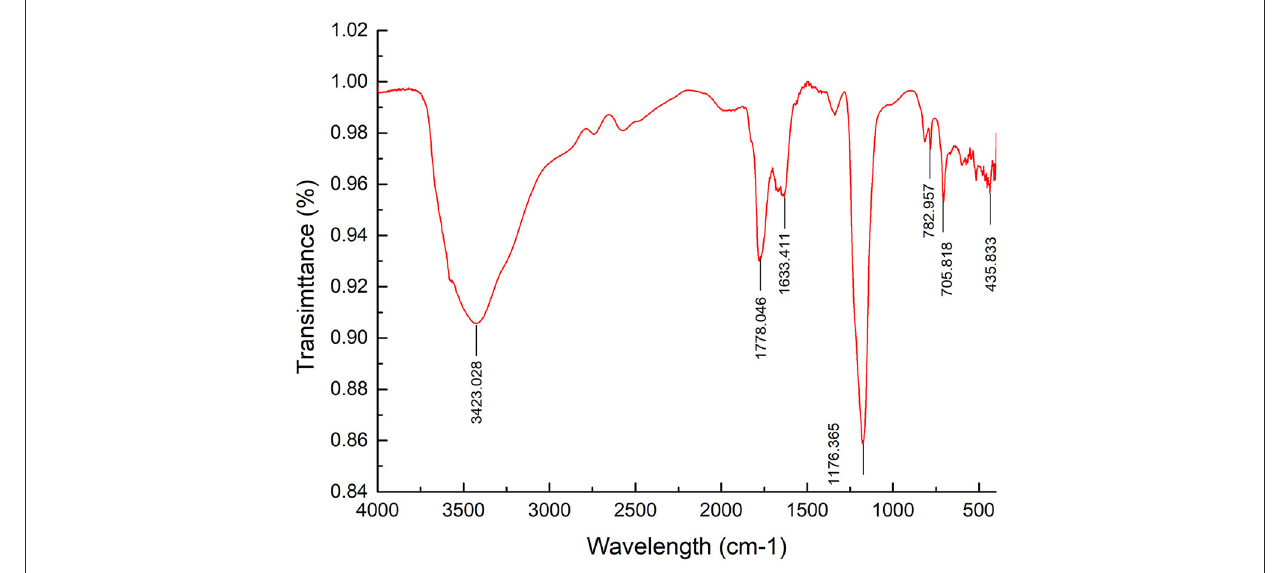
FIGURE2 FT–IR spectrum of A. polytricha glycoprotein APL.